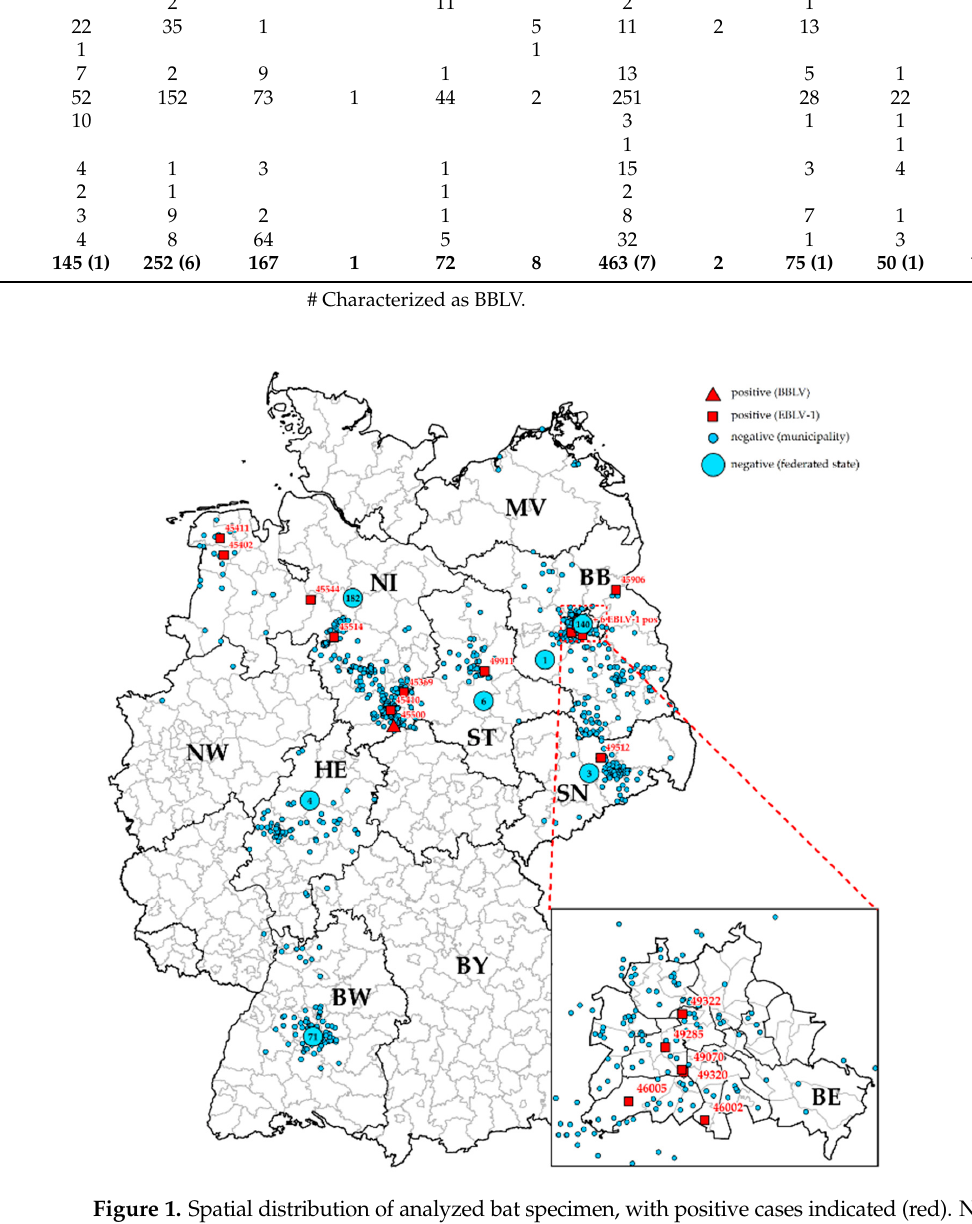
Figure 1. Spatial distribution of analyzed bat specimen, with positive cases indicated (red). Numbers in larger circles correspond to specimen for which detailed information on the origin was not available. Red dashed box: area of Berlin enlarged to visualize the distribution of samples.